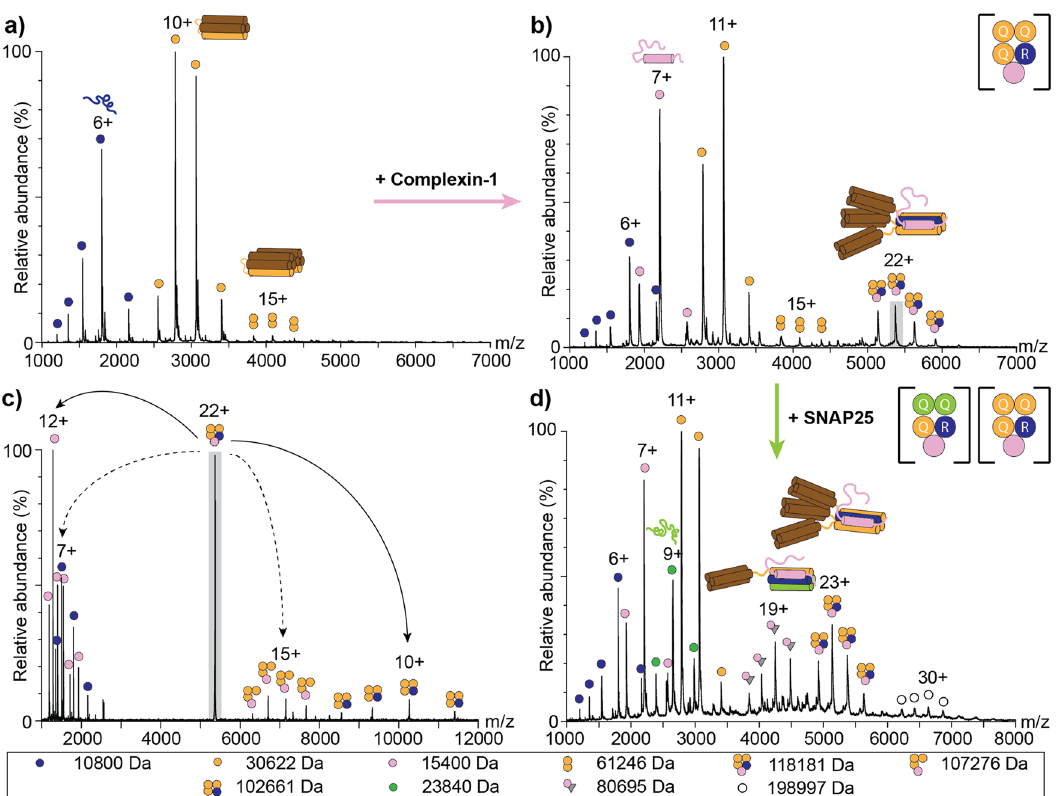
Fig. 4 The binary Synaptobrevin-2:Syntaxin-1A complex is stabilised by Complexin-1. a Synaptobrevin-2 and Syntaxin-1A were mixed in a 1:1 ratio and analysed by native MS. Charge state series corresponding to monomeric Synaptobrevin-2 (blue circle) and Syntaxin-1A (orange circles) were observed. b Addition of Complexin-1 to Synaptobrevin-2 and Syntaxin-1A results in formation of the 1:3:1 Synaptobrevin-2:Syntaxin-1A:Complexin-1 complex. Charge state series of monomeric Synatobrevin-2 (blue circles), Syntaxin-1A (orange circles) and Complexin-1 (pink circles), dimeric Syntaxin-1A (orange twin- circles) as well as the 1:3:1 complex (orange-blue-pink circles) are assigned. c The 22 + charge state of the 1:3:1 complex (highlighted in grey in panel b was selected for collision induced dissociation. Dissociated peripheral subunits (Synaptobrevin-2, blue circles; Complexin-1, pink circles) as well as two stripped complexes (3:1 Syntaxin-1A:Complexin-1, orange-pink circles; 3:1 Syntaxin-1A:Synaptobrevin-2, orange-blue circles) are assigned. d Complex formation upon equimolar addition of SNAP25 to the pre-assembled 1:3:1 Synaptobrevin-2:Syntaxin-1A:Complexin-1 complex was followed by native MS. Monomeric Synaptobrevin-2 (blue circles), SNAP25 (green circles) and Complexin-1 (pink circles) as well as the observed complexes (grey triangle-pink circle; blue- yellow-pink circles) are assigned. The observed molecular weight is given for all proteins and complexes (see